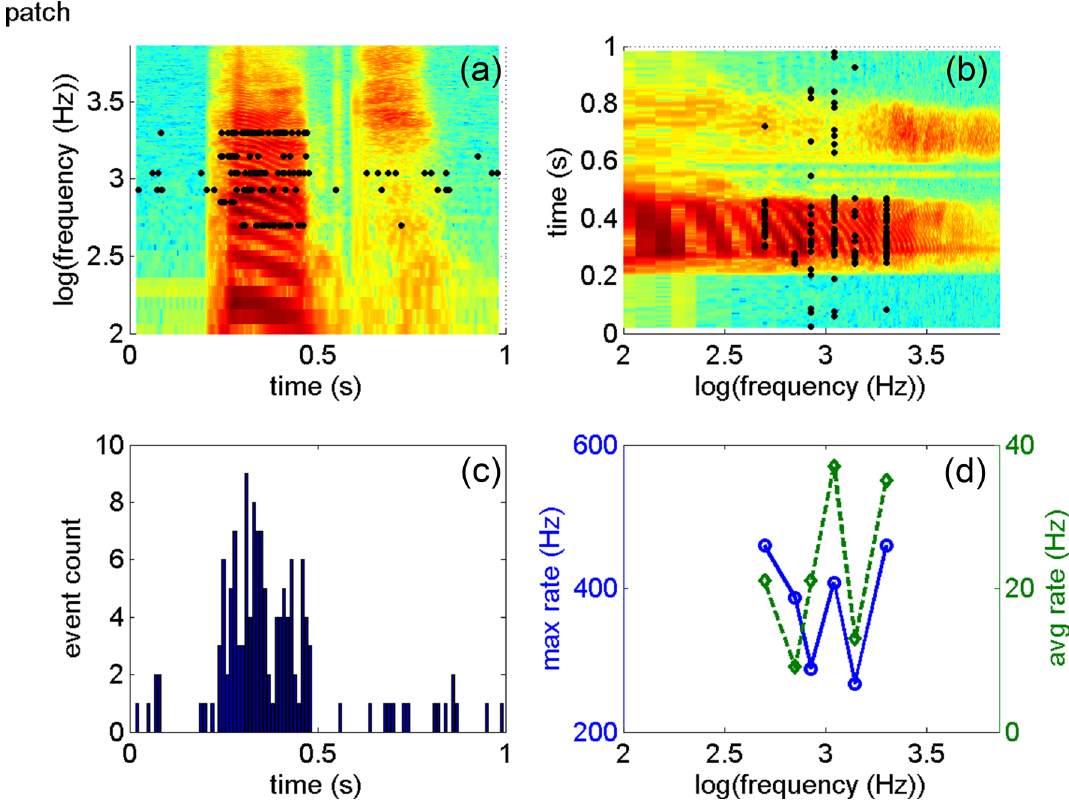
Figure 2. ( a ) Shows the spectrogram of the word “patch” overlaid by the black dots of the electrodogram (cochlear implant stimulation pattern). The electrodogram was constructed from the recordings in the guinea pig central nucleus of the inferior colliculus obtained while the word “patch” was played at an average sound level of about 60 dB SPL. ( c ) Shows the sum of the pulses in one bin (~ 22 µs). The more events are counted in a bin, the louder the stimulus will be. ( b ) Shows the spectrogram again with flipped axis. ( d ) Provides the corresponding average rate in one channel and the maximum rate as calculated from the shortest time between two pulses. The average rate is low. However, when stimulation occurs, it is between 300 and 500 Hz. The rate changes dynamically. Intensity pattern could be used as a cue in the processing of the encoded acoustic information.